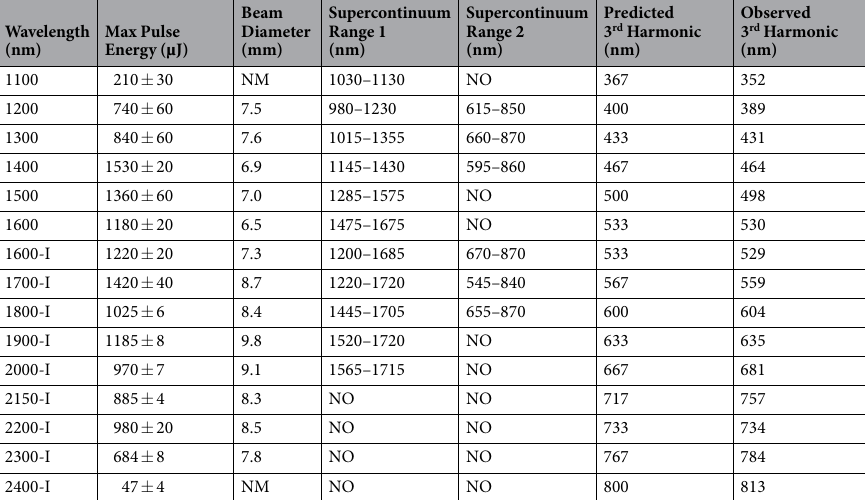
wavelengths 29,30 . In this experiment, the fringes were generally less intense than the third harmonic light, with the harmonic wavelength for each source wavelength. We find that our wavelength measurements for the observed third harmonics were within 6% of the predicted wavelength values. We also report the supercontinuum spectral